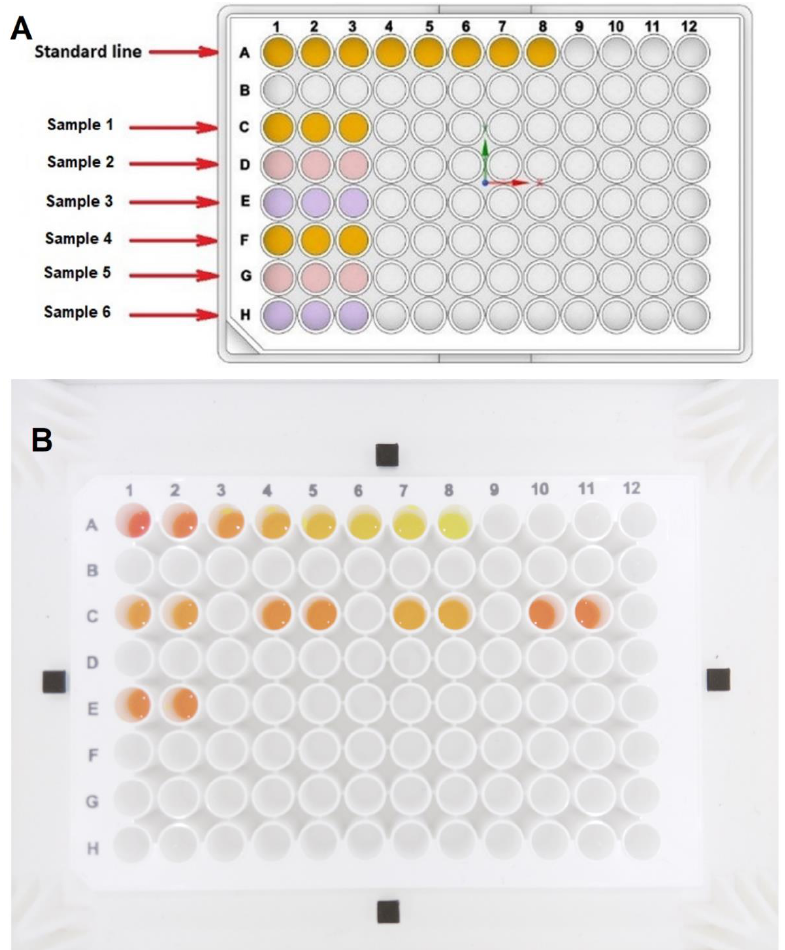
Figure 3. The 96-well microplates with the example of creatinine solutions. ( A ) The sketch of the 96-WM with the standards in wells A(1 – 8) and the testing solution in other wells; ( B ) An image of the creatinine solutions taken by the Raspberry Pi camera in the proposed colorimetry device.